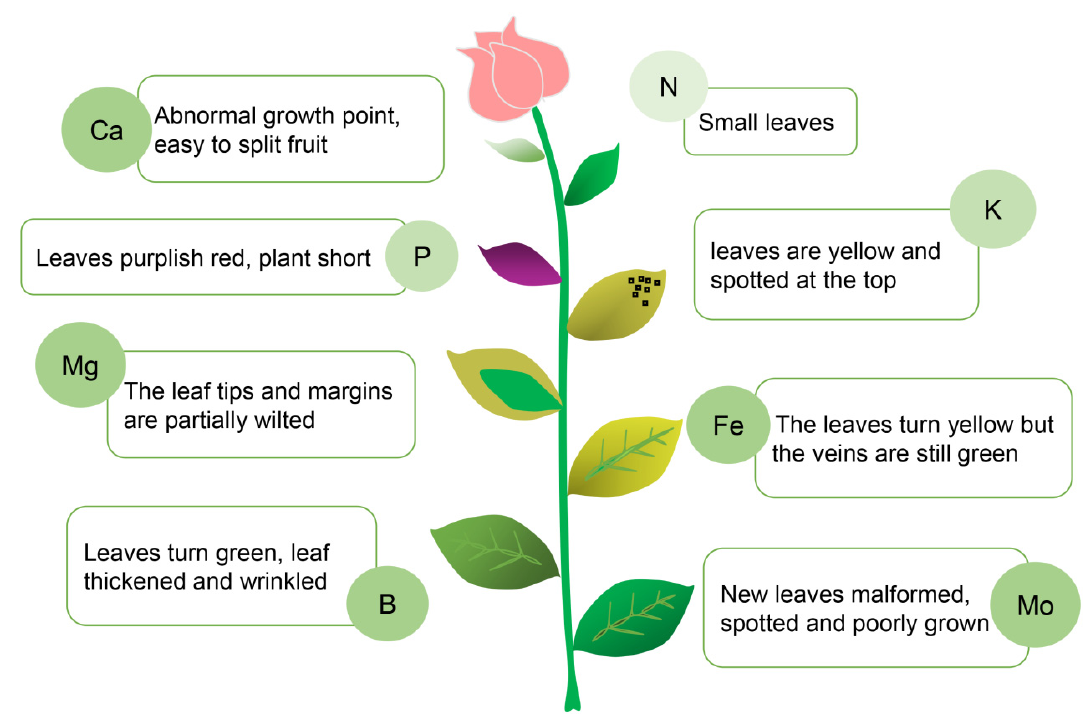
Figure 3. The effects of specific mineral nutrient deficiency on plants. The nutritional status of a plant is reflected in leaf shape and leaf color. Based on the information collected by visualizing the leaves, the appropriate nutrients can be supplied to the plant in a targeted manner to achieve precise fertilization. This chart is an example of a moonflower.